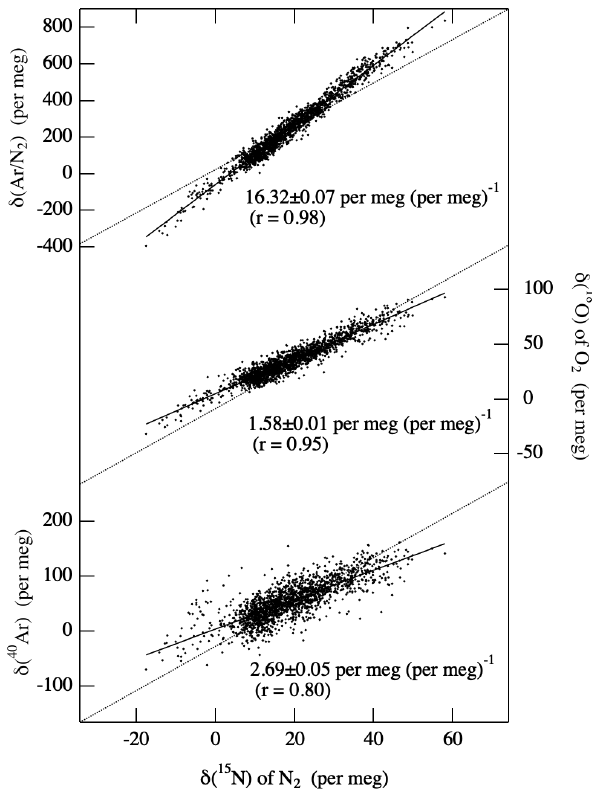
Figure 2. Measured δ (Ar / N 2 ), δ ( 18 O) of O 2 and δ ( 40 Ar) plotted against δ ( 15 N) of N 2 for all the collected air samples (solid dots). Least-squares regression lines fitted to the data are shown as solid lines, while the relationships expected from mass-dependent frac- tionation of air molecules are shown by dotted